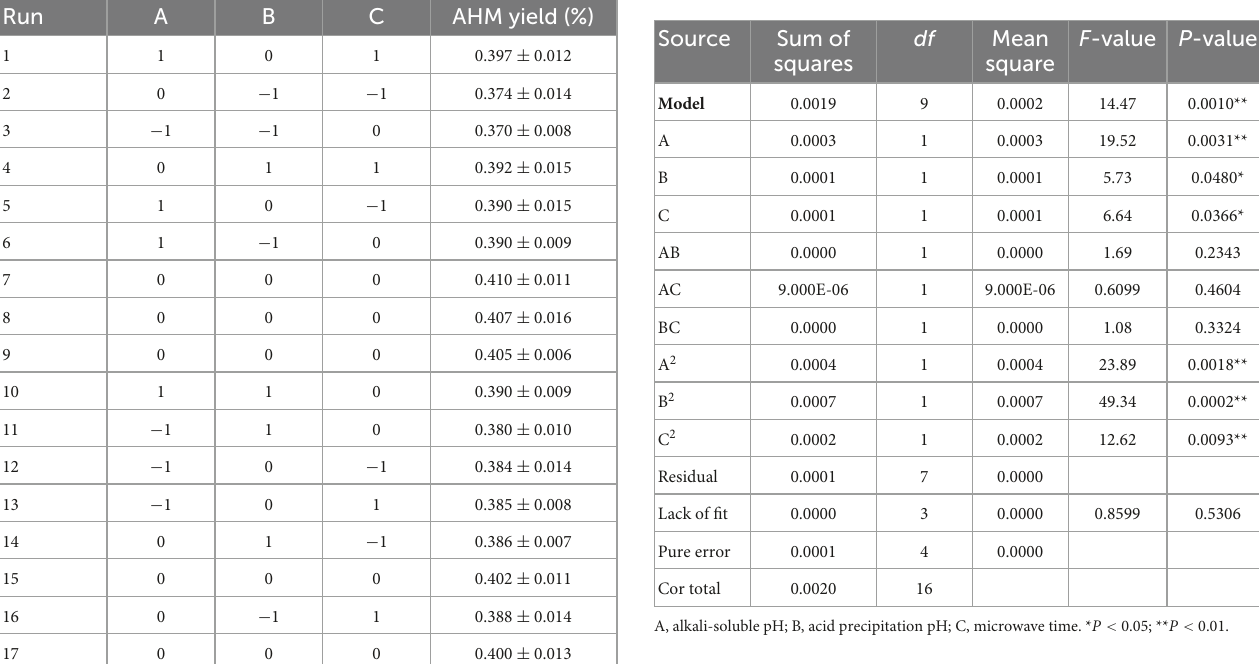
TABLE 2 The Box–Behnken experimental design and resulting AHM yield. TABLE 3 The analysis of variance (ANOVA) of the response surface regression